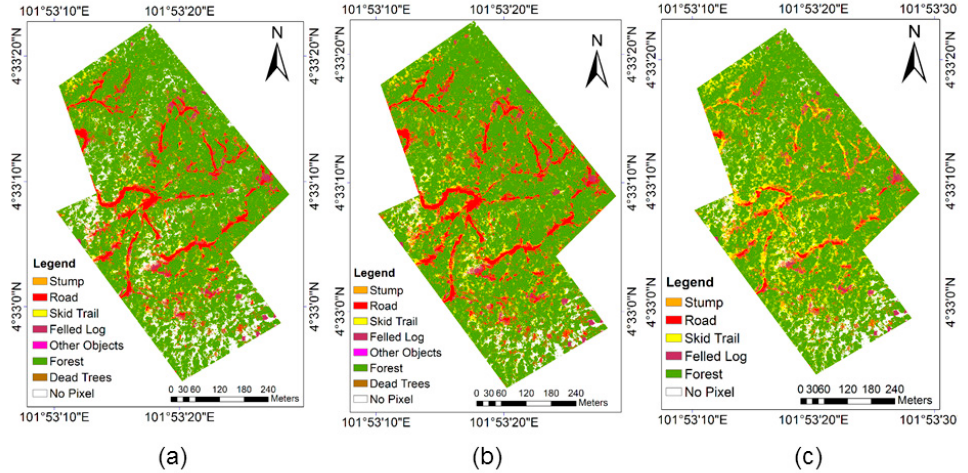
Figure 12. Classified ANN maps showing all the impacts of selective logging over Ulu Jelai Area with ( a ) 500 iterations; ( b ) 700 iterations; and ( c ) 1000